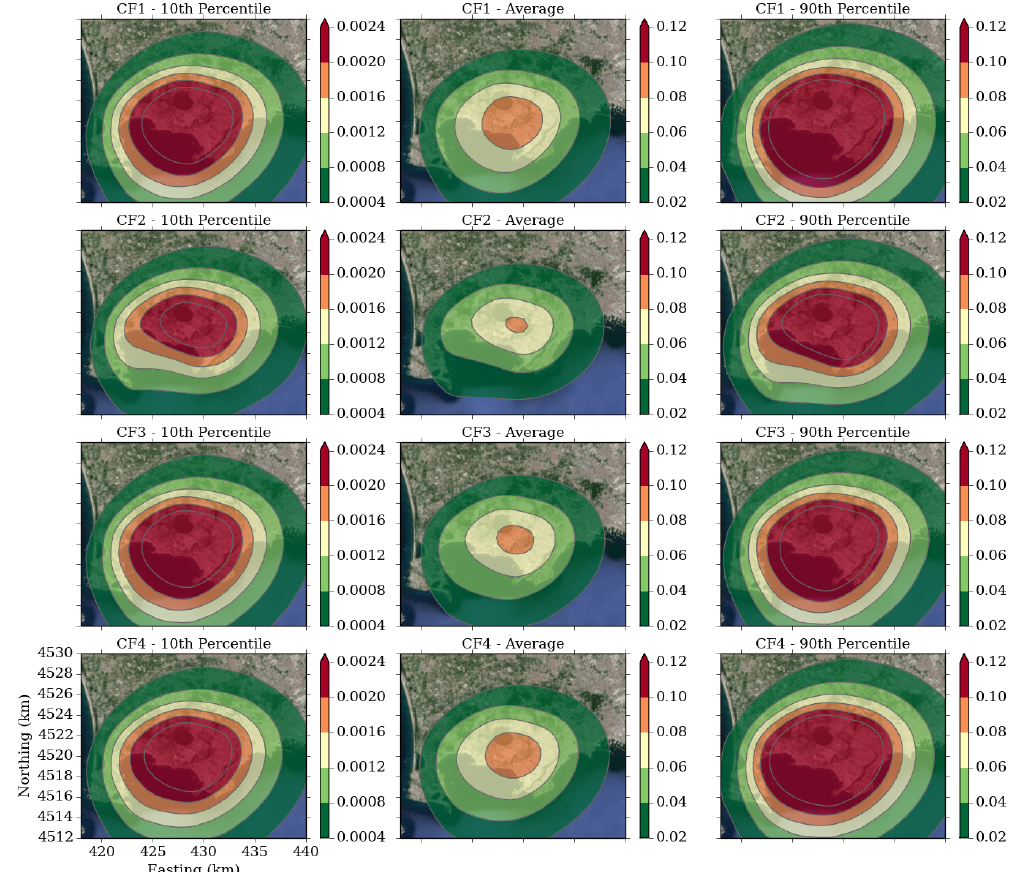
Figure 2. PVHA based on H1, H2, H3 and H4 hypotheses at CFc are shown from top to bottom respectively (CF1, CF2, CF3 and CF4). The middle column panels show the best guess (average) value for the probability of observing a tephra load larger than 3kPa in 50 years due to CFc magmatic eruptions, according to the PVHA model adopted. Left and right column panels show respectively the corresponding 10th and 90th